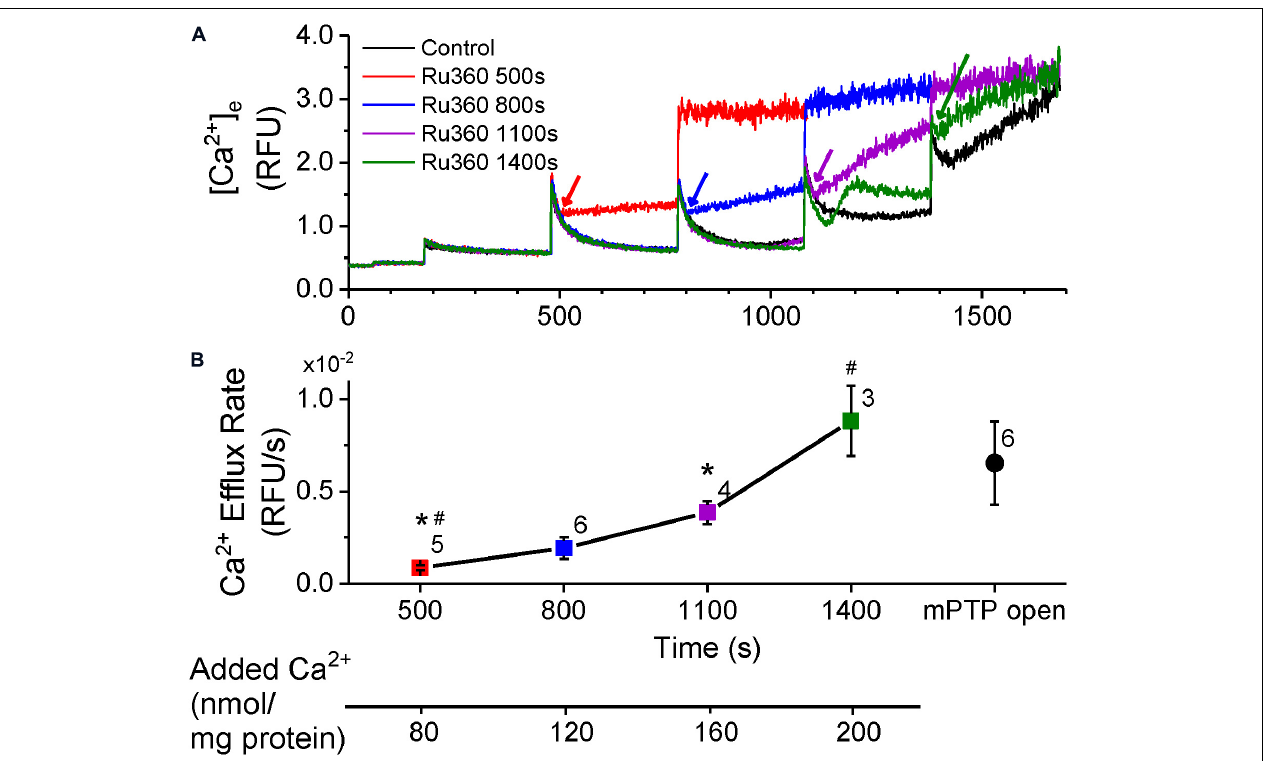
FIGURE 1 | Ca 2 + -efflux increases with total matrix Ca 2 + . (A) Extra-matrix Ca 2 + measured as relative fluorescence changes in Na + -free experimental buffer loaded with the Ca 2 + -sensitive ratiometric dye Fura-4F. 20 µ M CaCl 2 pulses were added first at 180 s and at every 300 s thereafter, in the absence (control, black trace) or the presence of MCU-inhibitor Ru360 (1 µ M) added at different times as follows: red trace – 500 s; blue trace – 800 s; purple trace – 1110 s; green trace – 1400 s. Times of addition of Ru360 are indicated by color-matched arrows. (B) Efflux rates obtained from the slope values (m) calculated from fits (y = m ∗ x + c) to the linear phase of Ca 2 + efflux from 5 s to 1 min after addition of 1 µ M Ru360 in each trace in (A) . Symbol colors correspond to the trace colors and conditions as specified in (A) . The efflux rate for Control (black circle) was obtained by fitting the equation (y = e − ( x − t )/ τ + m*x + c) to changes in Ca 2 + when mPTP opens (1380 s onward in control in A ). Numbers besides symbols denote the number of experiments for each data point. The scale below the X -axis shows the cumulative Ca 2 + added before the corresponding time-point of efflux rate calculation. *, # indicates significant difference ( p < 0.05) between indicated